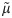
Schematic of the model used to evaluate SGV and rescue, illustrated for ploidy c = 4.(A) Flow diagram of all events. A cell is represented by a grey oval, containing four chromosomes (complete or partial, so long as they contain the gene of interest). These chromosomes are colored blue if wild-type at the gene of interest or red if mutant. A cell either divides to produce two daughter cells with type-specific probability pj or otherwise dies. These probabilities pj differ between the old environment (to model SGV) and the new environment (to model rescue). Upon type 0 division, mutation (producing type 1) occurs with probability μ∼ in each daughter cell; otherwise, the daughter is also type 0. In the remaining types, chromosome segregation determines the types of the daughter cells. (B) A mechanistic view of chromosome replication and segregation, illustrated for the production of one type 2 and one type 0 daughter cell from a type 1 mother cell. On each chromosome, the black dash indicates the origin of replication. SGV, standing genetic variation.